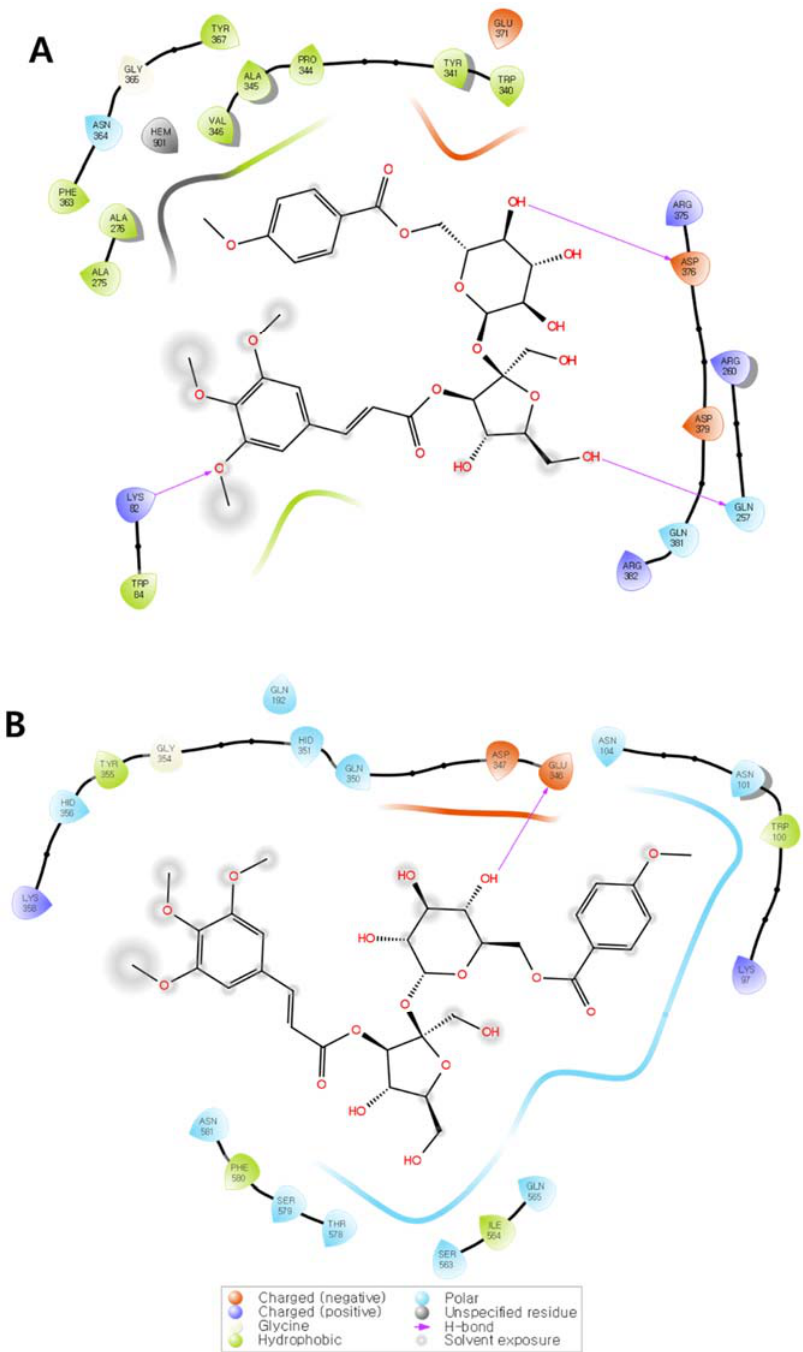
Figure 7. Receptor–ligand interaction diagram of TCMB ( 11 ) with the iNOS ( A ) and COX ‐ 2 ( B ) protein. The lowest docking position was selected for ligand interaction study (RMSD < 1.0). Only interacting residues were colored according to the following description: Negatively charged residue is red, positively charged residue is violet, hydrophobic residue is turquoise, polar residue is light blue, and glycine is white. HEM ‐ 901, a cofactor molecule, is colored by gray. Hydrogen bond interactions are indicated by pink arrows. Solvent exposure moiety is indicated by soft ‐ edged gray circle. Visual illustrations of the receptor–ligand interaction diagrams were generated by Maestro software.